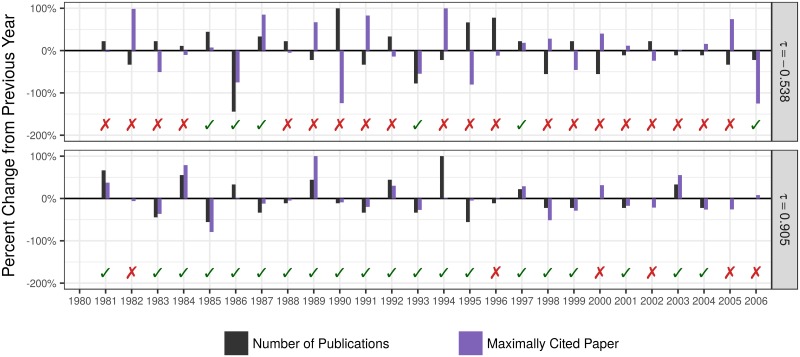
Example trajectories of scientists who experience a trade-off or concordance.The percent change in productivity (black) and quality (specifically the number of citations received by the maximally cited paper in that year; purple) from the previous year. Years in which the two changes are both of the same sign are termed concordant (green check-mark), while years in which the sign of the change differs are termed discordant (red X). The top scientist experiences a strong trade-off (low τ, many discordant years), while the bottom scientist experiences strong concordance between quantity and quality.